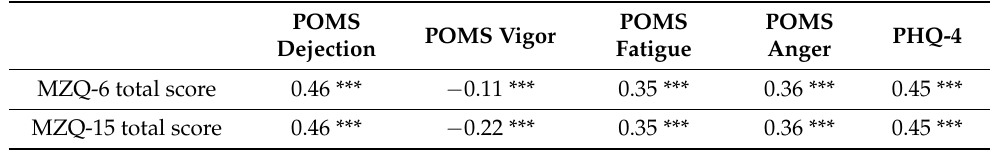
Table 4. Correlations of MZQ-15 and MZQ-6 total score with POMS-16 subscales scores and PHQ- 4